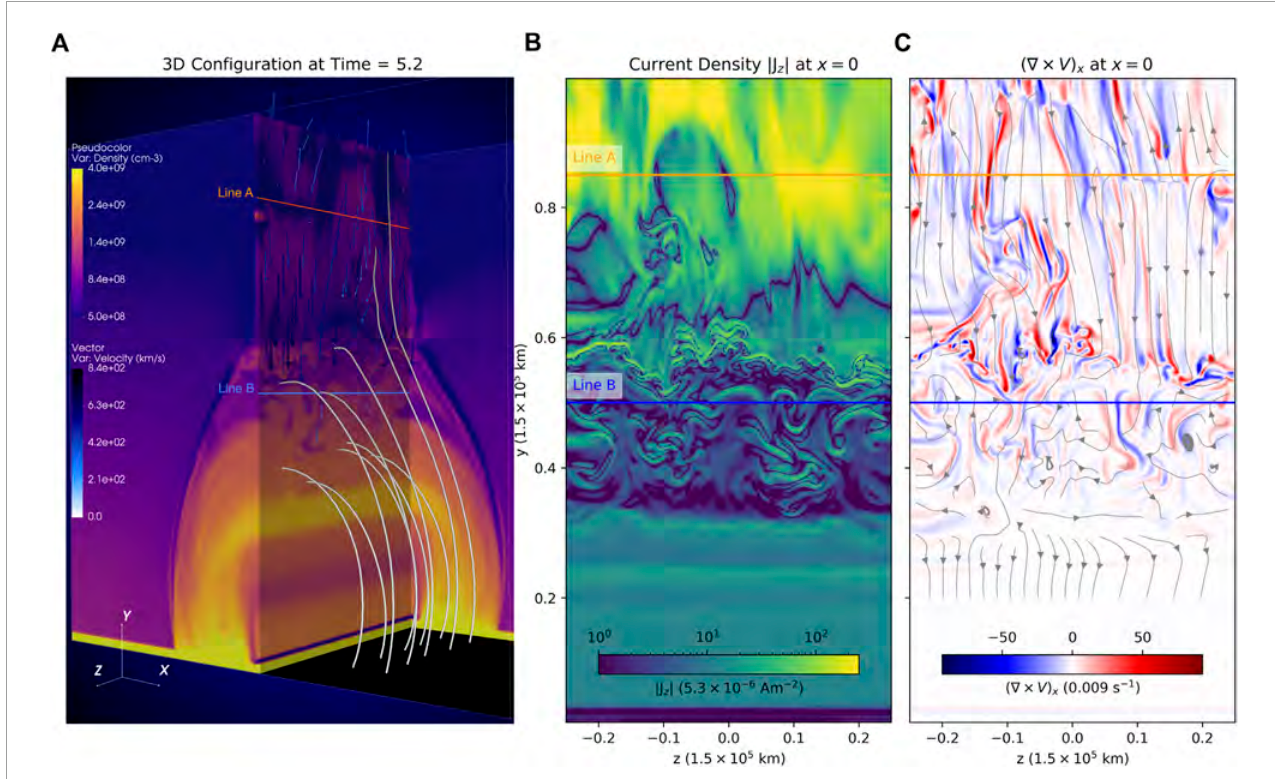
FIGURE 5 Distribution of primary variables in a 3D flare model at time = 5 . 2 t 0 . (A) Density and velocity distribution on the chosen planes in 3D. The gray tubes indicate magnetic field lines, and the black/blue arrows are for plasma flows. Along the LOS direction, two sampling lines A and B are chosen on the central plane ( x = 0 ) . (B) Current density at the central plane. (C) Velocity vorticity component ( ∇ × V ) x on the central plane. The streamlines show velocity fields ( V y , V z )